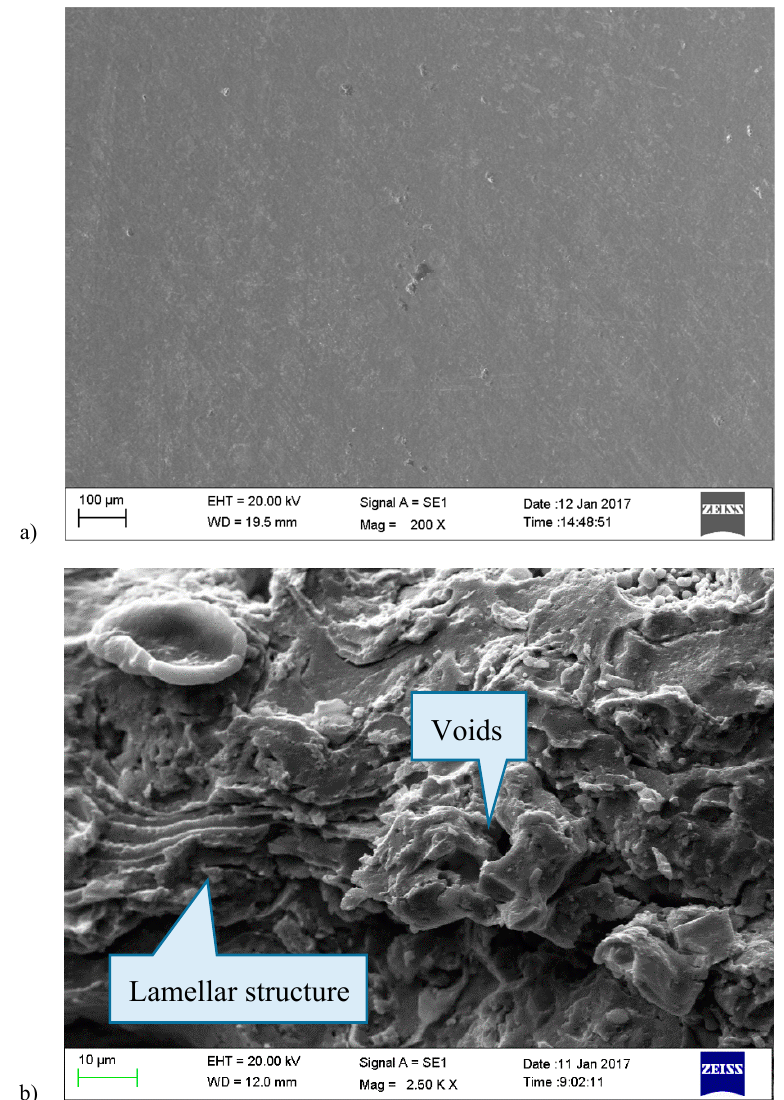
Figure 5. SEM images showing the shrouded plasma-sprayed Ti coatings. ( a ) the polished cross-section; ( b ) the fractured cross-section.